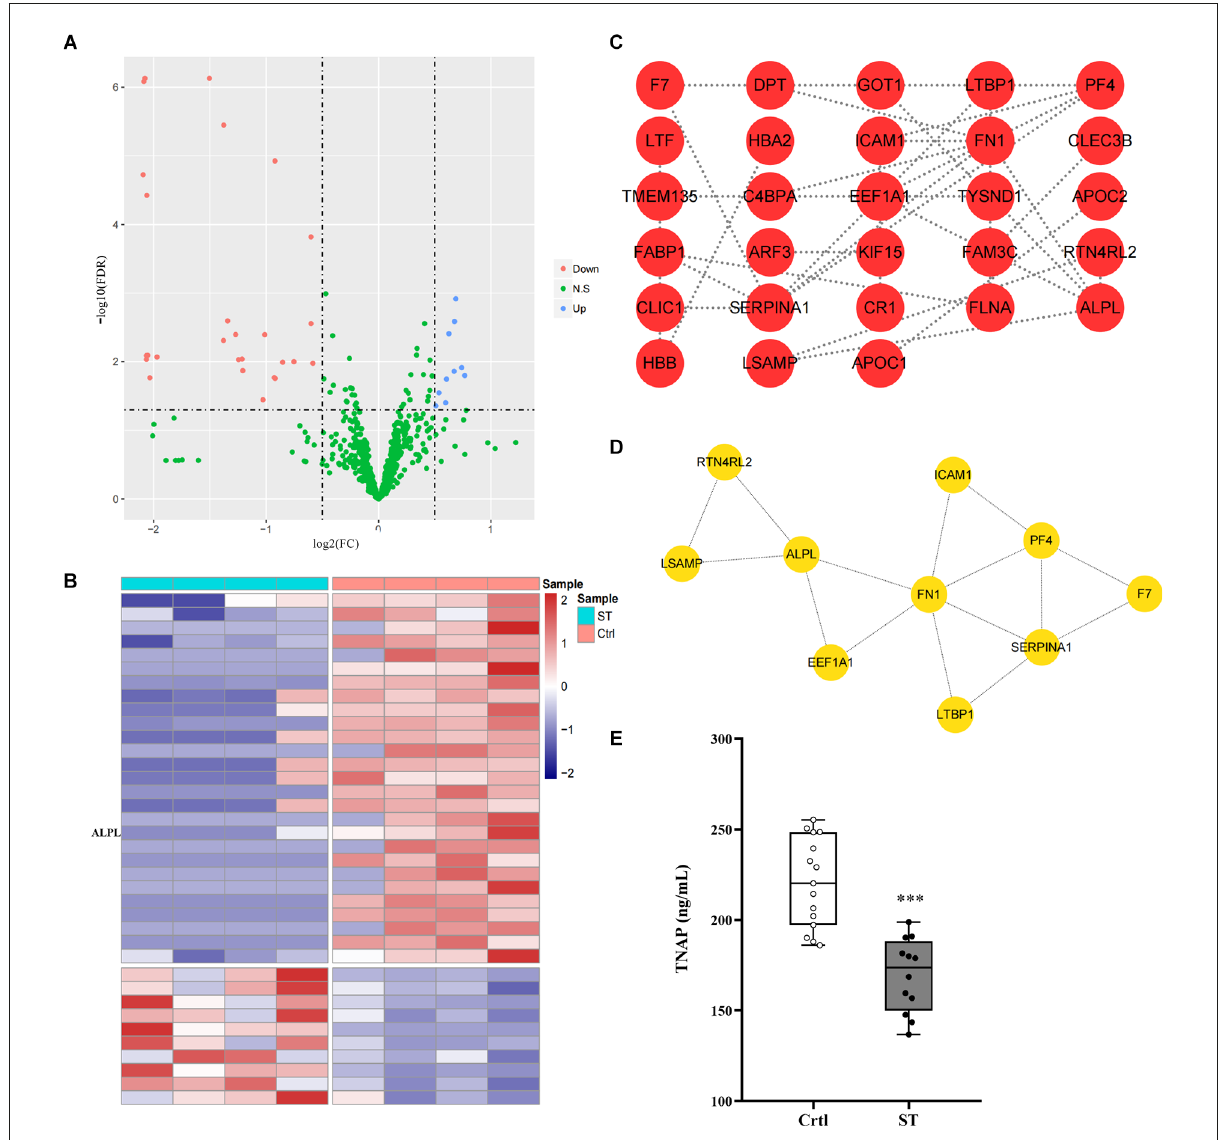
FIGURE2 (A,B) Volcano map and heatmap showing 37 differentially expressed proteins between the ST group and the Ctrl group. The red and blue dots represented upregulated and downregulated proteins, respectively, and green represented proteins with no significant difference. The co-differential genes RP1 , ALPL , and FABP1 identified by expression profile chip detection and mass spectrometry detection were marked in panel (B) . (C) |Log2Fc| > 0.5 and FDR < 0.05 were used as the criteria for screening differentially expressed proteins. The PPI network diagram showed the differentially expressed proteins in the plasma of children in the ST group and the Ctrl group. Each dot in the network represented a protein, and the connection between the dots represented the relationship between them. The more connected lines there were, the more important the protein may be in the PPI network (minimum required interaction score > 0.4). (D) The top 10 genes in terms of degree in the PPI network screened by the MNC algorithm according to the test results of the plasma protein profiles of the children in the ST group and Ctrl group; the lines between the dots represented the relationship between them. (E) The content of TNAP in the plasma of children in the ST group and Ctrl group. Compared with that in the control group, the expression level of TNAP in the plasma of children in the spastic type CP group was significantly lower ( p < 0.001, n = 12 for ST; n = 15 for Ctrl). ∗∗∗ p < 0.001 vs.